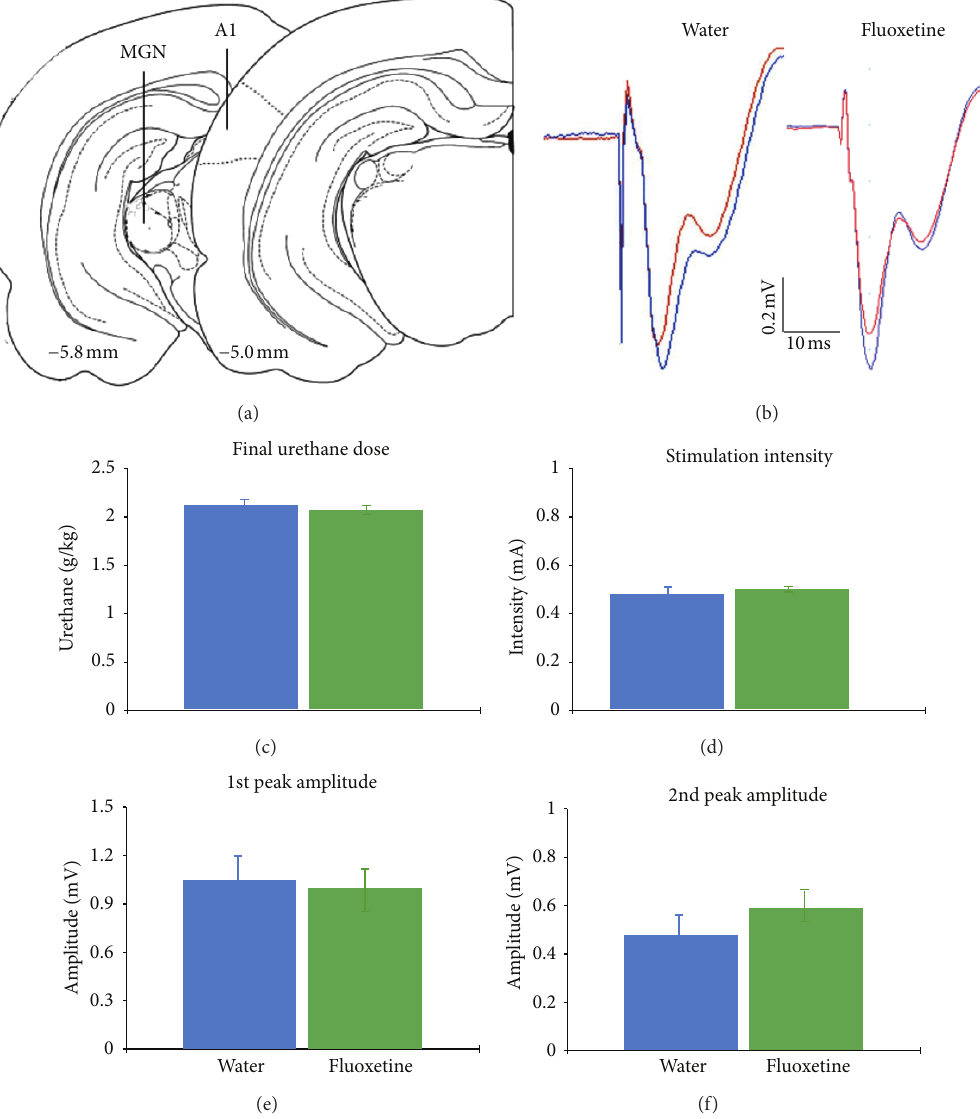
Figure 2: (a) Schematic diagram of electrode placements in the medial geniculate nucleus (MGN) and primary auditory cortex (A1); numbers indicate distance (in mm) from bregma. Diagrams adapted from Paxinos and Watson [40]. (b) Field postsynaptic potentials (fPSPs) recorded in A1 in response to single pulse MGN stimulation consisted of two successive, negative-going peaks. (the initial, sharp, negative spike is the stimulation artifact.) Red and blue traces are taken before and after theta-burst stimulation of the MGN, respectively. Note the absence of clear potentiation of the second fPSP peak in the fluoxetine-treated rat. (c) Final urethane dose required for anesthesia induction in the two treatment groups. (d) Stimulation intensities used for the electrophysiological experiments. (e) Baseline (pre-LTP induction) amplitude of the first fPSP peak. (f) The second fPSP peak recorded in A1 of rats given access to drinking water ( 𝑛 = 11 ) or water containing fluoxetine (0.2 mg/mL; 𝑛 = 14 ) during a 4-week treatment period. Statistical analyses for all comparisons did not reveal any significant group